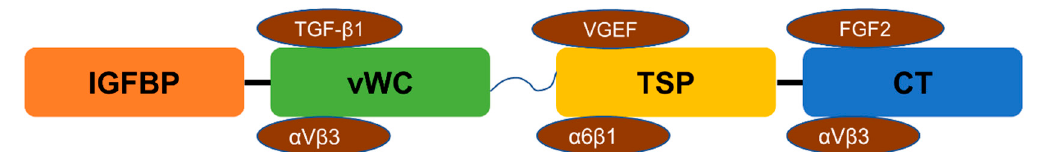
Figure 1. The structure of CCN protein and examples of their binding growth factors / integrins. The structure (from left to right) consists of insulin-like growth factor binding protein (IGFBP), von Willebrand factor type C repeat (vWC), thrombospondin type 1 repeat (TSP), and cysteine knot (CT). Transforming growth factor β 1 (TGF- β 1), fibroblast growth factor (FGF2), vascular endothelial growth factor (VEGF), and the integrins ( α V β 5, α 6 β 1, and α V β 3) are shown binding with each section.